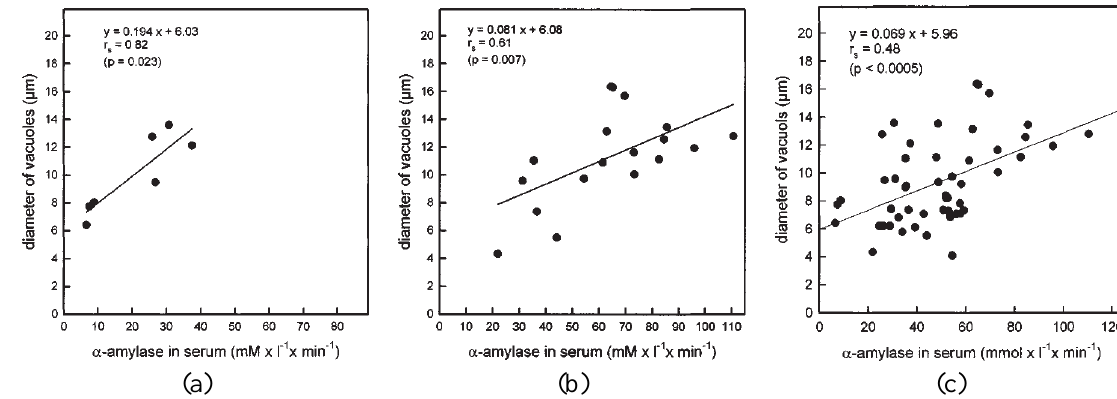
a n gives the number of animals. b WGA: wheat germ agglutinin.